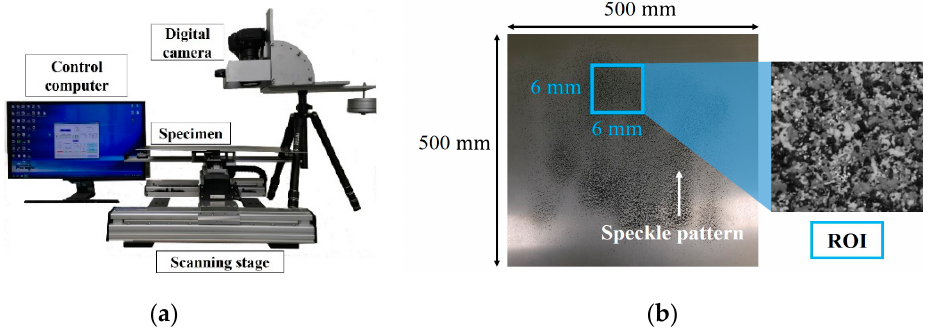
Figure 2. Experimental setup: ( a ) data acquisition system, ( b ) aluminum plate specimen and the target region of interest